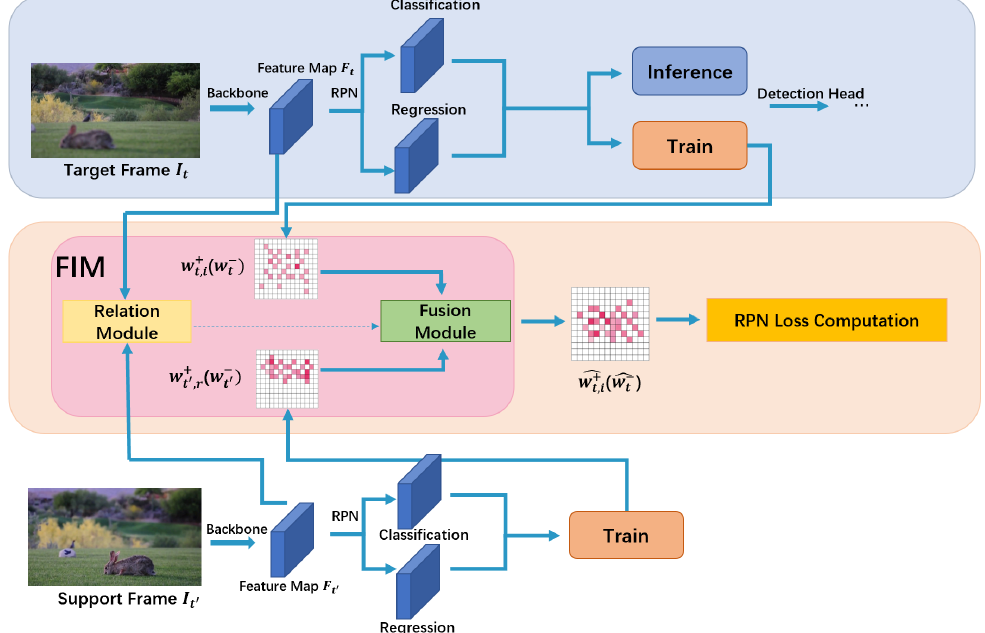
Figure 2. The architecture of our temporal guided label assignment (TGLA). The temporal-guided label assignment framework is presented by the upper blue box and the lower orange box, which denote forward propagation and loss computation separately. Note that the framework we mentioned below does not include feature instructing. Furthermore, we put forward an feature instructing module (FIM), which utilizes feature maps to guide the fusion of weight